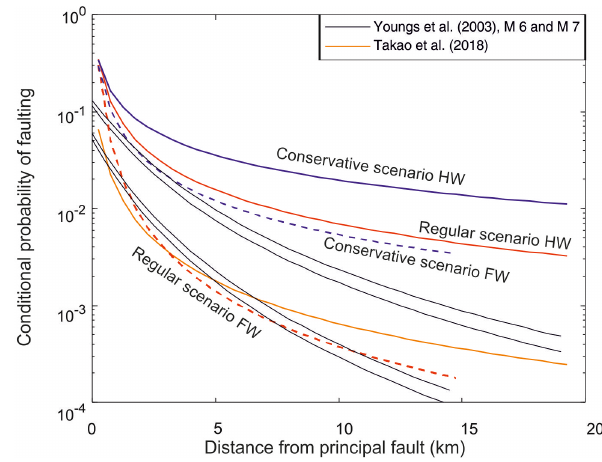
Figure 7. Comparison between the conditional probability of fault- ing for normal events obtained in this study and those from Youngs et al. (2003; the curves for M 6 and 7 are shown as a reference) and for strike-slip and reverse events in Japan (Takao et al., 2018); full lines represent the hanging wall, and dashed lines represent the